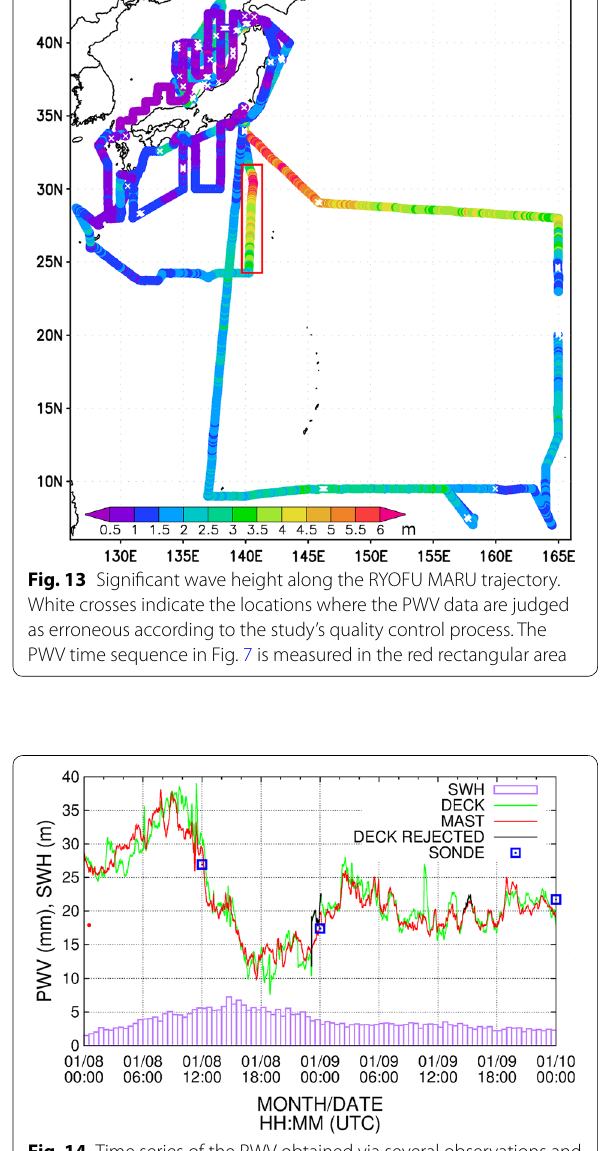
Fig. 14 Time series of the PWV obtained via several observations and a NWP analysis from 0000 UTC on January 8 to 0000 UTC on January 10, 2017. The blue squares indicate the radiosonde, the red line indicates MAST, the green line indicates DECK, the black line indicates DECK (rejected), and the purple boxes indicate the significant wave